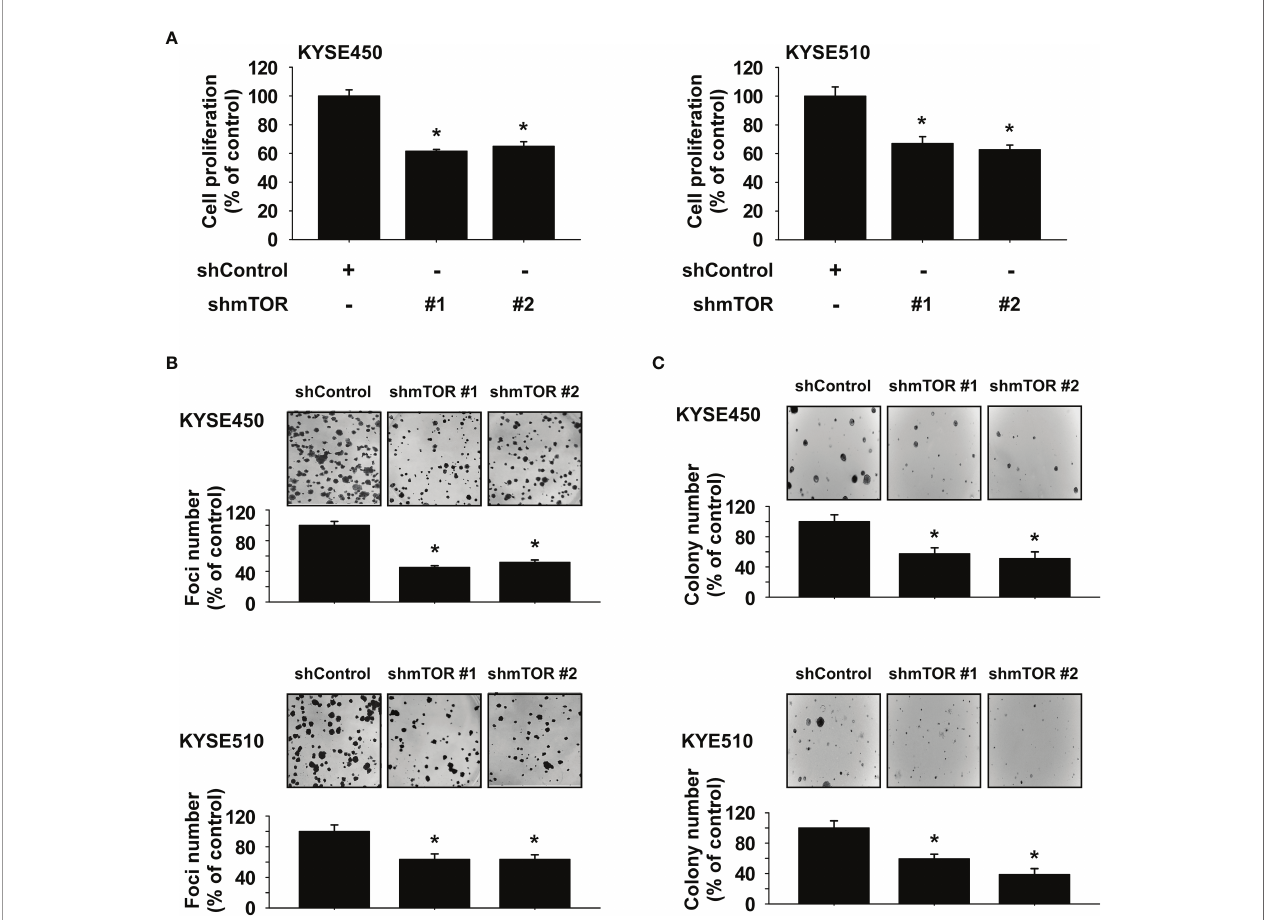
FIGURE 4 | Mammalian target of rapamycin (mTOR) is a therapeutic target in esophageal squamous cell carcinoma (ESCC) cells. (A) Effect of mTOR knockdown (shmTOR) on ESCC cell growth was determined by MTT assay. (B) Effect of mTOR knockdown (shmTOR) on focus formation ability of ESCC cells. Cells were incubated for 10 days, and then focus number was counted. (C) Effect on anchorage-independent growth of ESCC cells by mTOR knockdown (shmTOR). After incubation for 2 weeks, colony number was counted. For all, data are shown as means ± SD of values from 3 independent experiments, and the asterisk (*) indicates a signi fi cant ( P < 0.05) inhibitory effect of mTOR knockdown (shmTOR). One-way analysis of variance (ANOVA) with Dunnett ’ s post-hoc test was used to compare signi fi cant